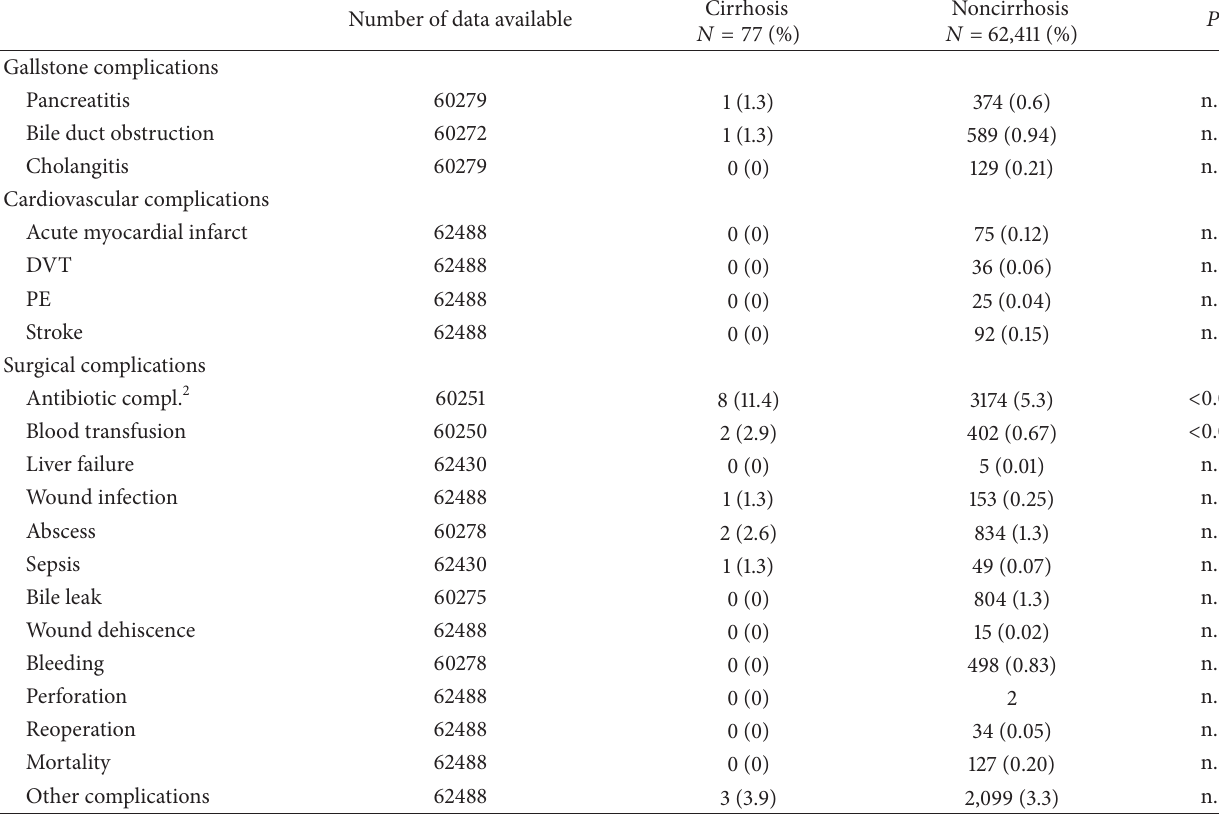
Table 2: Postoperative complications within 30 days after cholecystectomy 1